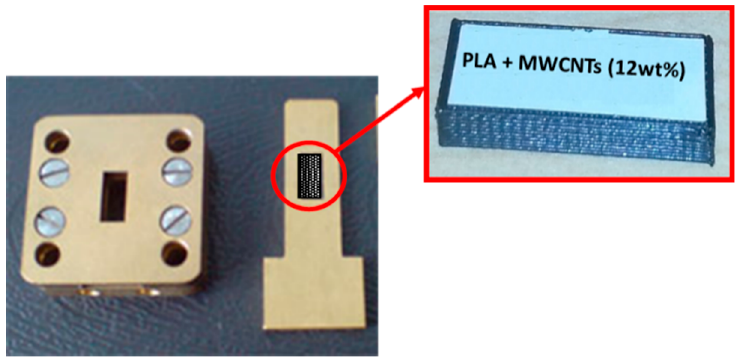
Figure 4. The 7.2 × 3.4 waveguide measurement cell.